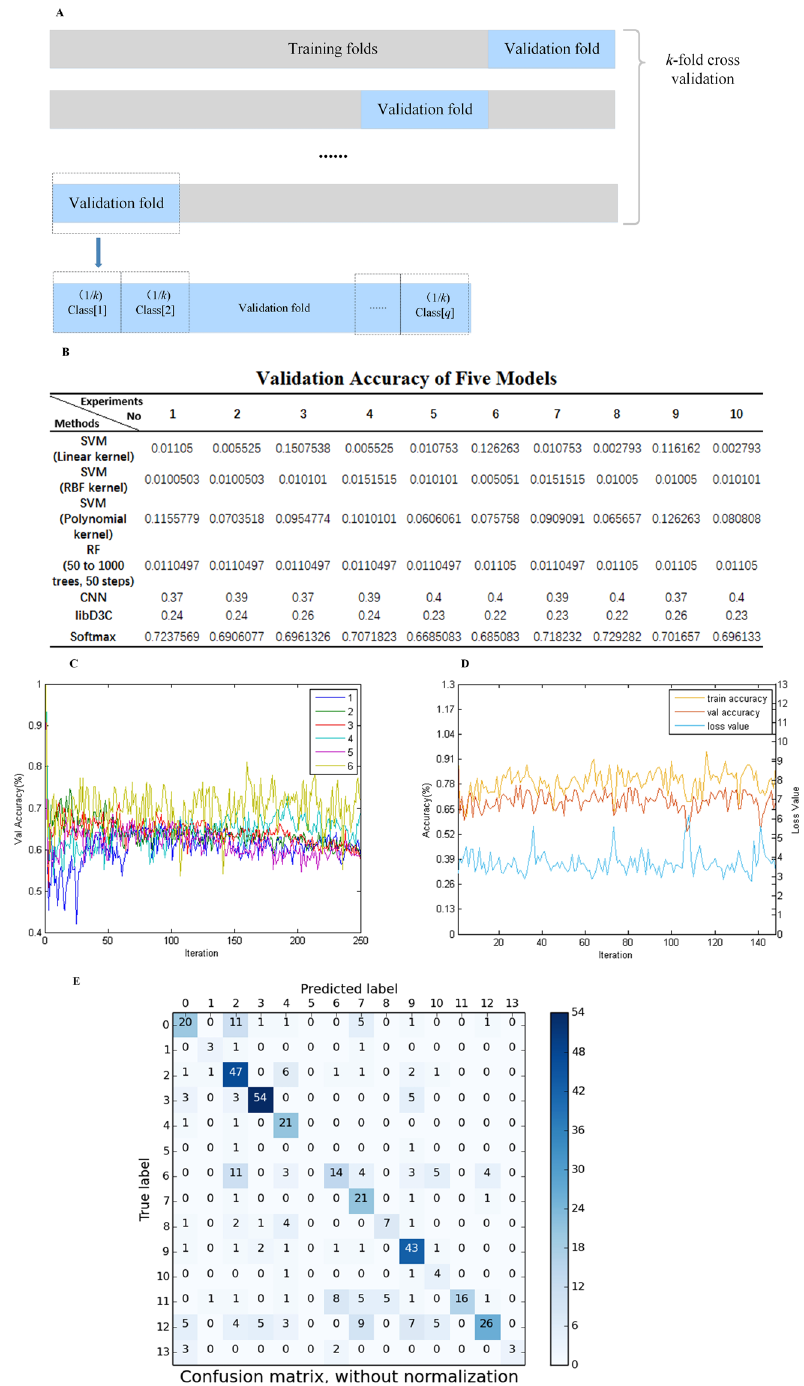
Figure 2. Experiment results of models. ( A ) k -fold cross-validation was used for setting hyper-parameters and evaluating generalizations. ( B ) The results from independent repeated experiments indicated that there was little prospect of prediction by using SVM with different kernel functions and RF. The mean performance of libD3C, which is the latest ensemble classifier, was slightly higher than 20%. The validation accuracy of CNN and Softmax was 40% versus 70%. ( C ) The learning curve of experimental results under different hyper- parameter settings, including learning rate, training threshold, validation threshold, and regularization weight. The best results were 0.06 of the learning rate, 0.30 of the training threshold, 0.06 of the validation threshold, and 1 of the regularization weight. ( D ) Softmax result under best hyper-parameter setting. The training accuracy was over 80%, and the validation accuracy was approximately 70%. ( E ) Confusion matrix representing Softmax classification performance. Each column of the matrix represents the instances in a predicted class, whereas each row represents the instances in an actual